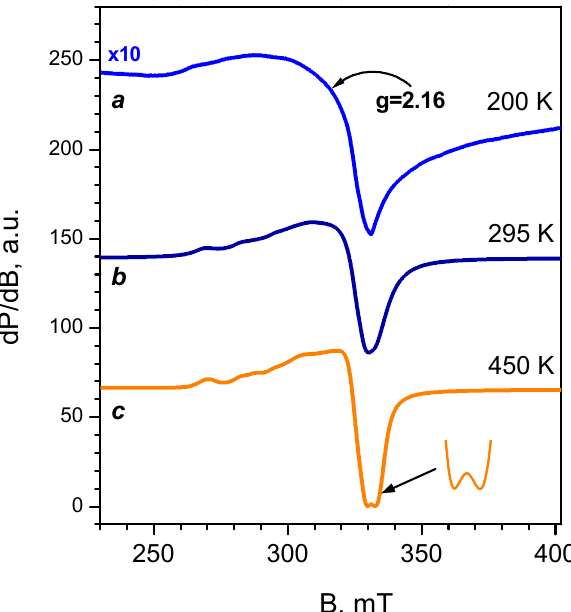
Figure 4. In situ EPR spectra of 2.3CuZ23(AE) annealed in O 2 at 400 °C recorded at different tem- peratures.